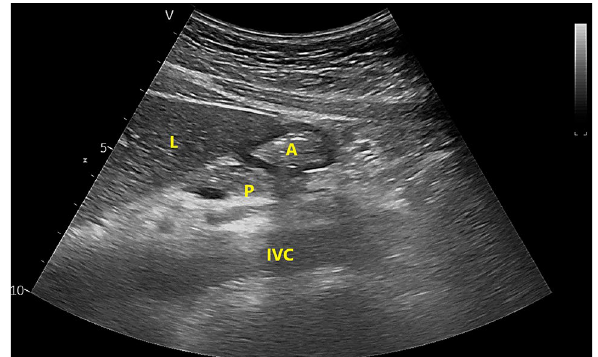
Figure 1. Ultrasound image of the gastric antrum in the epigastric area, obtained in the sagittal or parasagittal plane. A, antrum; L, liver; P, pancreas; IVC, inferior vena cava. The antrum is between the left lobe of the liver anteriorly and the pancreas posteriorly at the level of the aorta or the inferior vena